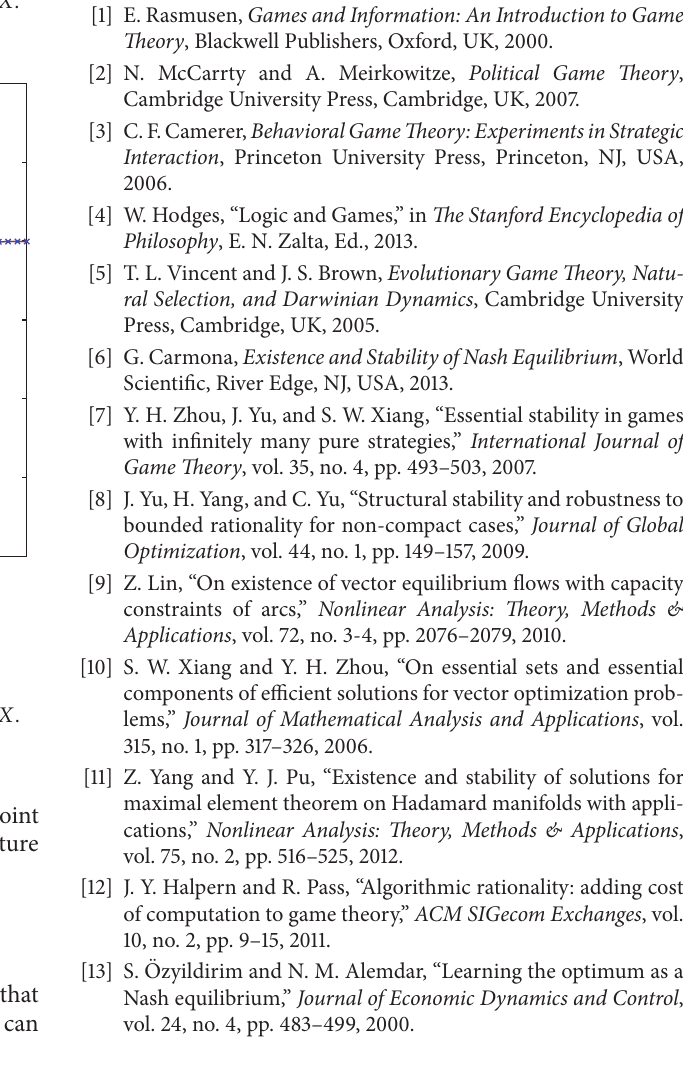
Figure 3: The state vector of system (30) with 𝑞 0 = [3,5] 𝑇 ∈ 𝑋 .